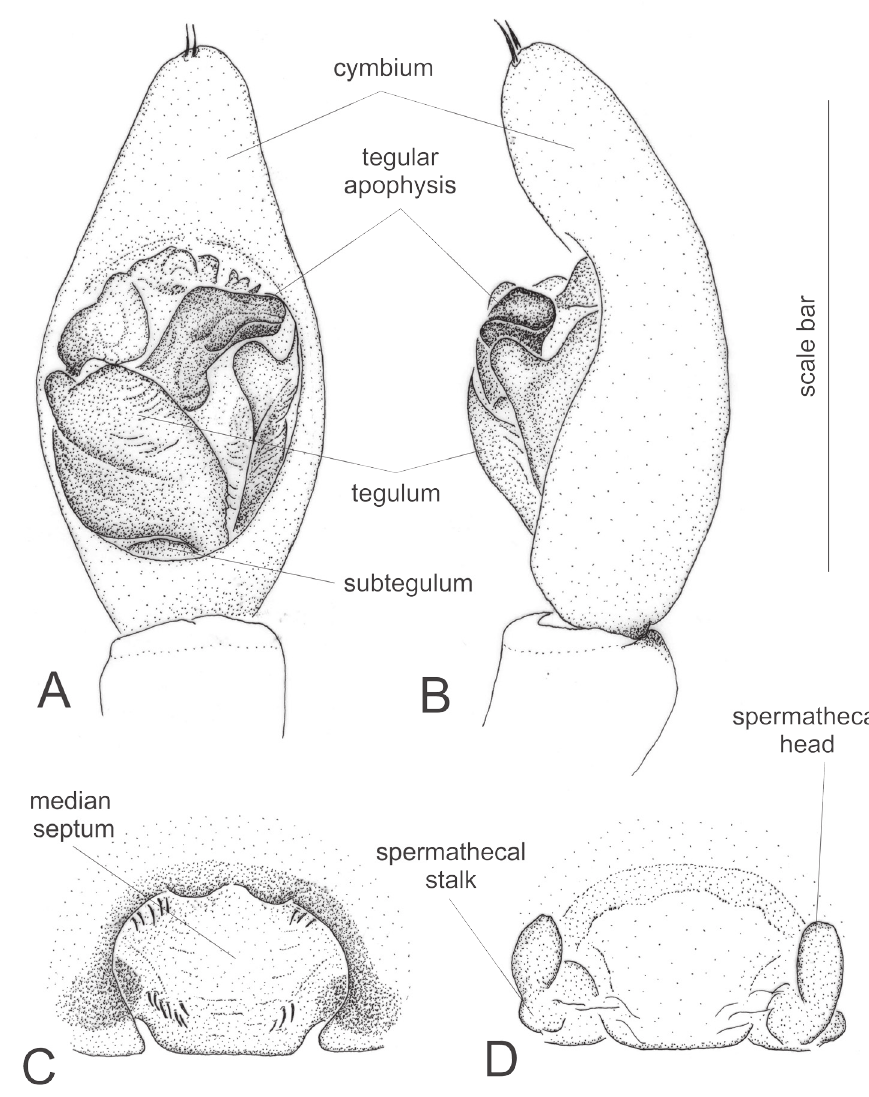
Fig. 27. Tetralycosa halophila sp. nov., ♂, holotype (SAM NN21734) and ♀, paratype (SAM NN21733) . A–B . Left male pedipalp, ventral and retrolateral view. C–D . Female epigyne, ventral and dorsal view. Scale bar: A–B = 2.78 mm; C–D = 1.43